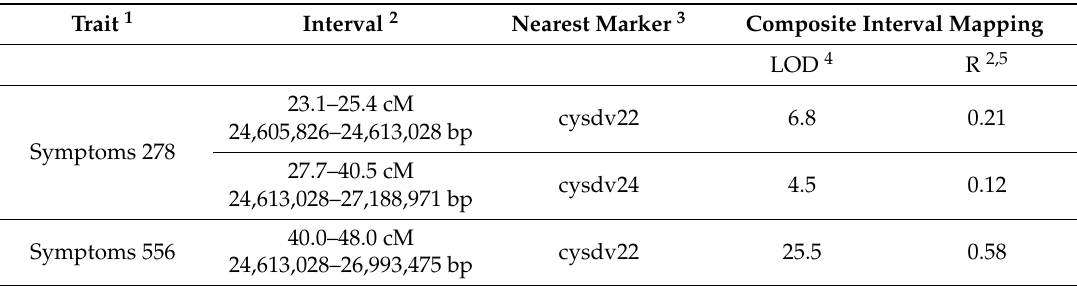
1 Trait: Symptom evaluation in the di ff erent progenies, BC 1 S 1 278 (Symptoms 278) and BC 1 S 1 556 (Symptoms 556). 2 Interval position of the putative QTL on the genetic and physical maps according to a LOD drop of 2. The physical position (v.3.6.1) is defined by the position of the markers flanking the QTL interval. 3 Closest marker to the LOD peak. Significance level in the Kruskal–Wallis test was 0.0001 for all the markers. 4 Higher logarithm of the odds score. 5 Percentage of phenotypic variance explained by the